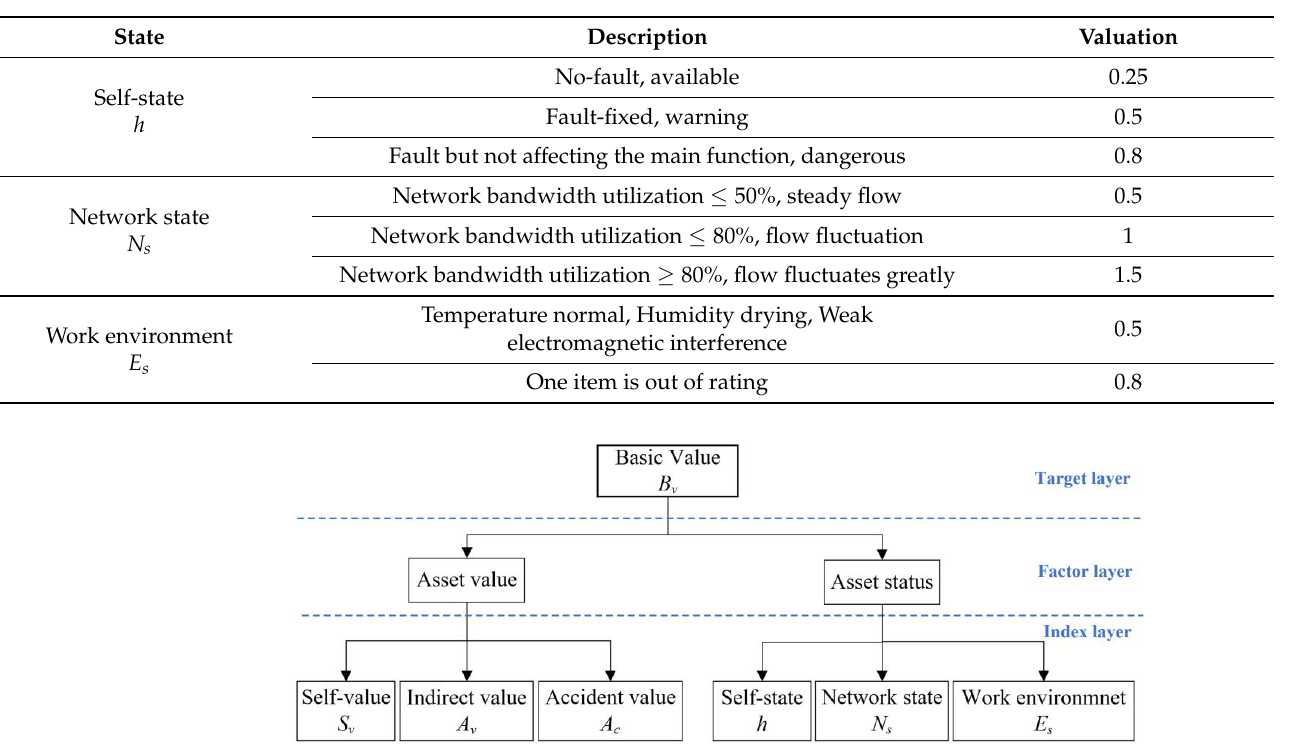
Table 1. Quantitative table of asset status.